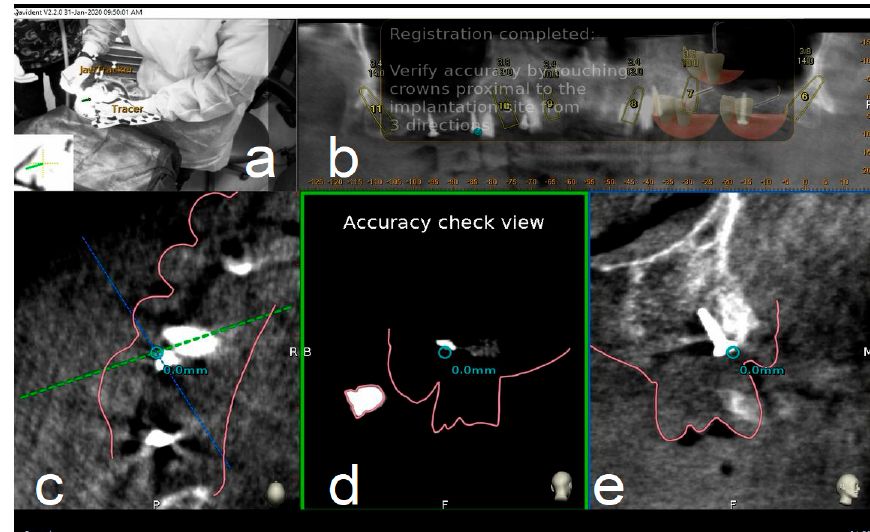
Figure 4. The surgeon ( a ) can then verify the registration accuracy ( b ) by touching with the tracer’s ball tip one of the patient’s landmark (mini screw used in this case) ( c ). The matching quality can be verified from each view ( d , e ).